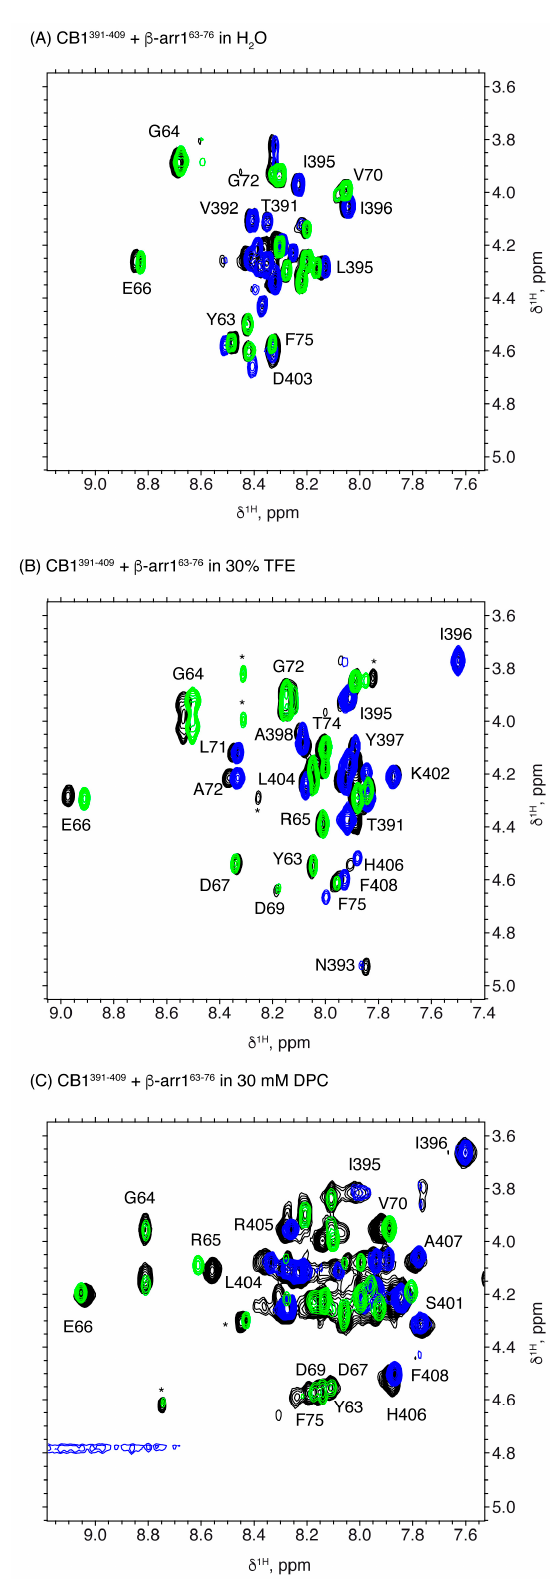
Figure 6. Overlay of selected regions of 2D 1 H, 1 H TOCSY spectra for CB1 391-409 + β -arr1 63-76 (black contours), CB1 391-409 (blue contours) and β -arr1 63-76 (green contours) in water ( A ), in 30 % TFE ( B ) and in DPC micelles ( C ). In all cases pH 5.5 and 25 °C.